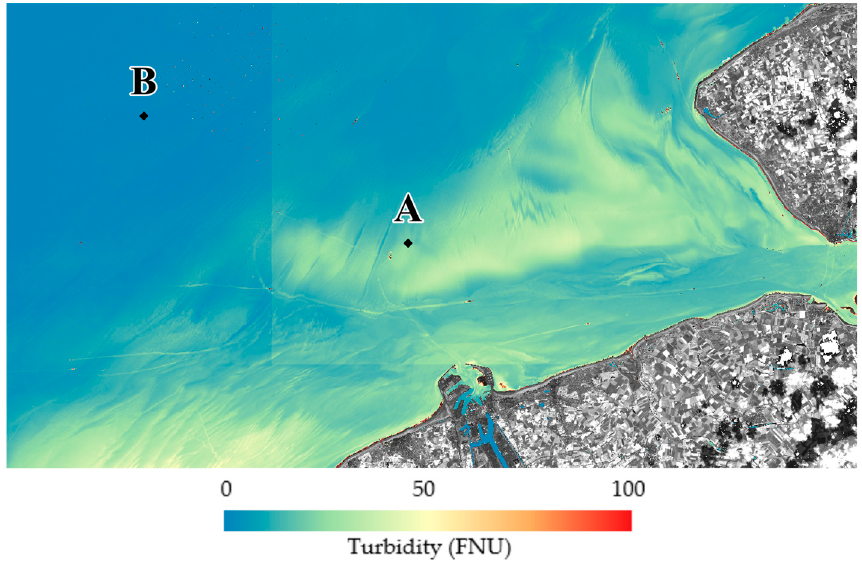
Figure 8. Sentinel-2 derived turbidity product on 13 April 2021 at 10:59 UTC. The two locations of drone flights are marked with A and B. Table 4. Turbidity values derived from Sentinel-2 MSI, DJI PH4pro and HACH in situ device for the two locations in the Belgian North Sea.